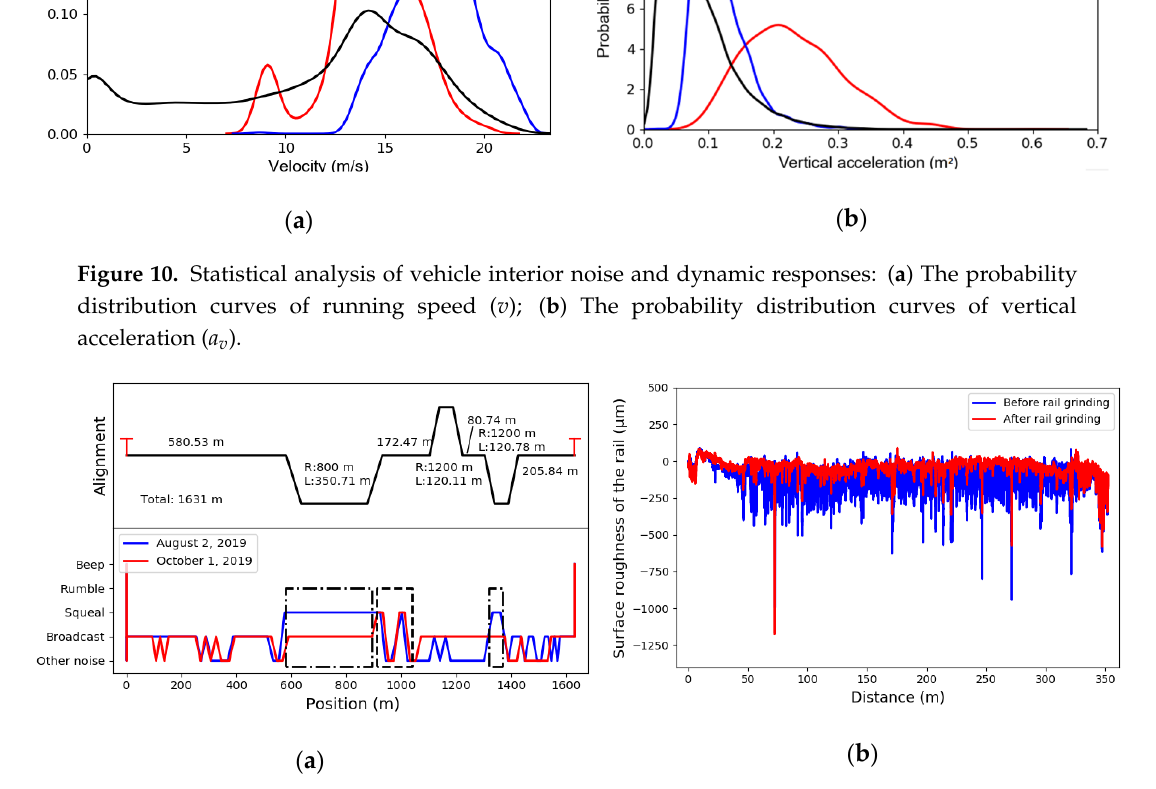
Figure 11. Abnormal events detection and rail grinding effect evaluation using the XGBoost multi-classification model: ( a ) track alignments of the test section and the identification results before and after rail grinding; ( b ) the surface roughness of the rail before and after rail grinding.